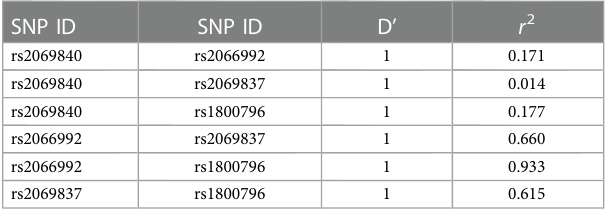
TABLE 5 Linkage disequlibrium analysis between IL-6